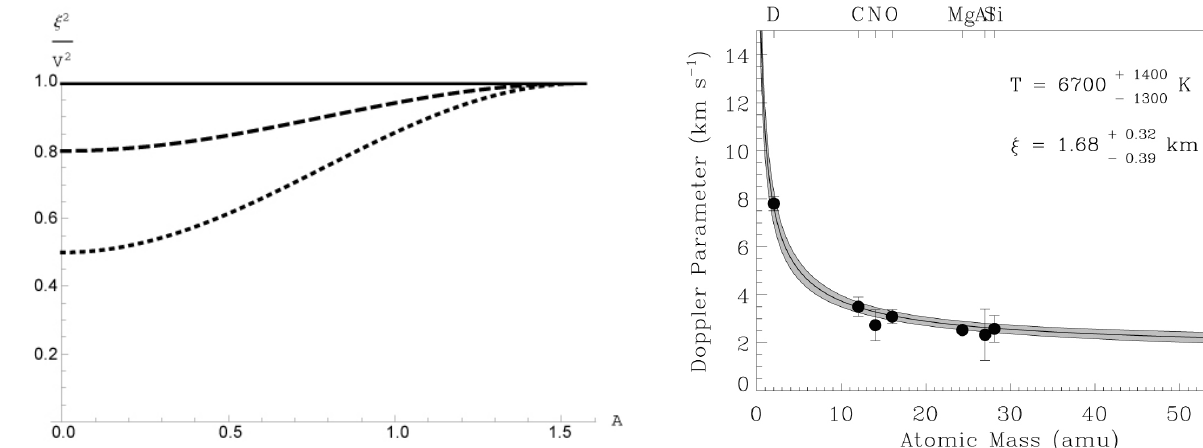
Fig. 4. Spectral line width b versus atomic mass for the absorption 2 line in Capella. Transitions from eight atoms or ions are included in as a function V 2 ⊥ this figure. The solid line indicates a fit of Eq. (1) with T = 6700K and ξ = 1 . 68kms − 1 , and the shading gives the ± 1 σ confidence range, given the errors in T and ξ . Taken from Redfield and Linsky